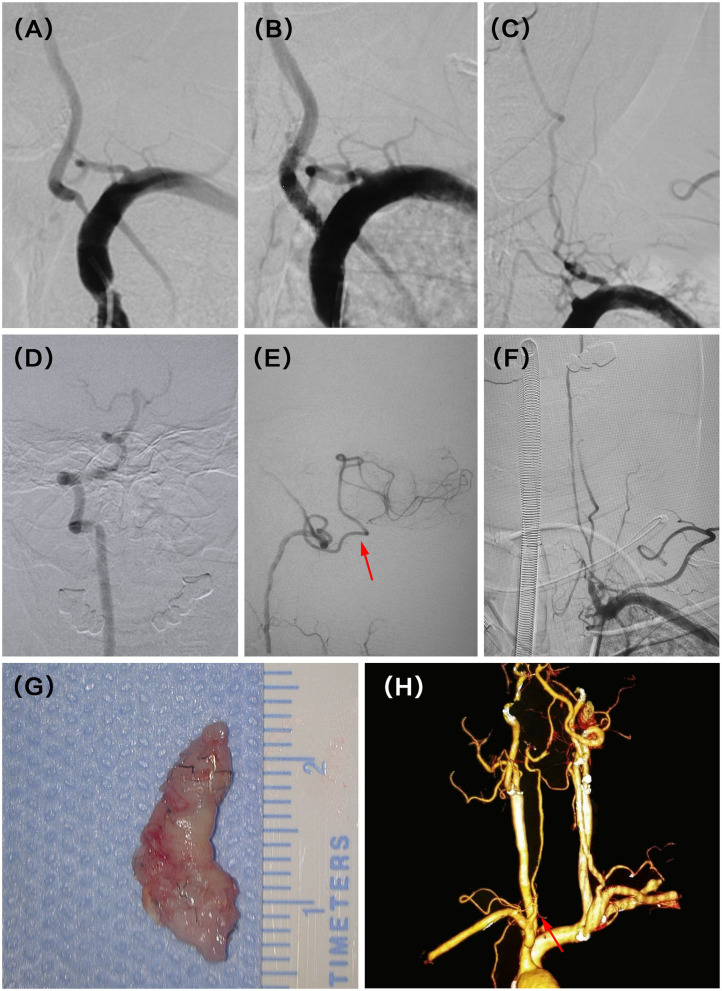
(A) Severe stenosis of the left vertebral artery (VA) ostium was observed in the digital subtraction angiography (DSA). (B) Revascularization was achieved with balloon and stent angioplasty. (C) DSA showed recurrent left V1 occlusion at the 5 months follow-up. (D) Intraoperative angiography demonstrated dominant right VA with the deficiency of ipsilateral PICA. (E) Intraoperative angiography also demonstrated symptomatic non-dominant left VA with a thin posterior inferior cerebellar artery (PICA) (red arrow). (F) Successful recanalization was then achieved with stent removal after vertebral endarterectomy (VEA). (G) The stent was seen clearly in the gross specimen. (H) CT angiography (CTA) indicated the patency of the left VA at the latest follow-up time (22 months) after hybrid surgery (red arrow).